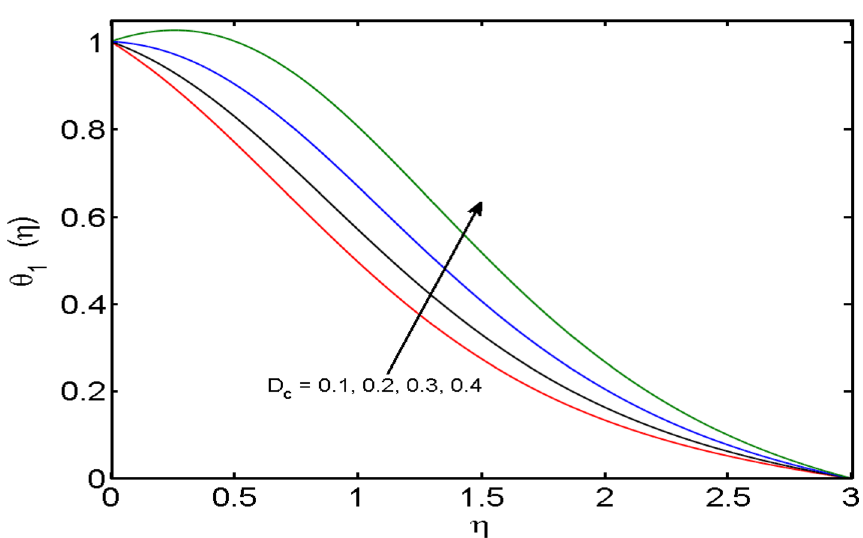
Figure 10. θ 1 (η) versus varied estimates of D c